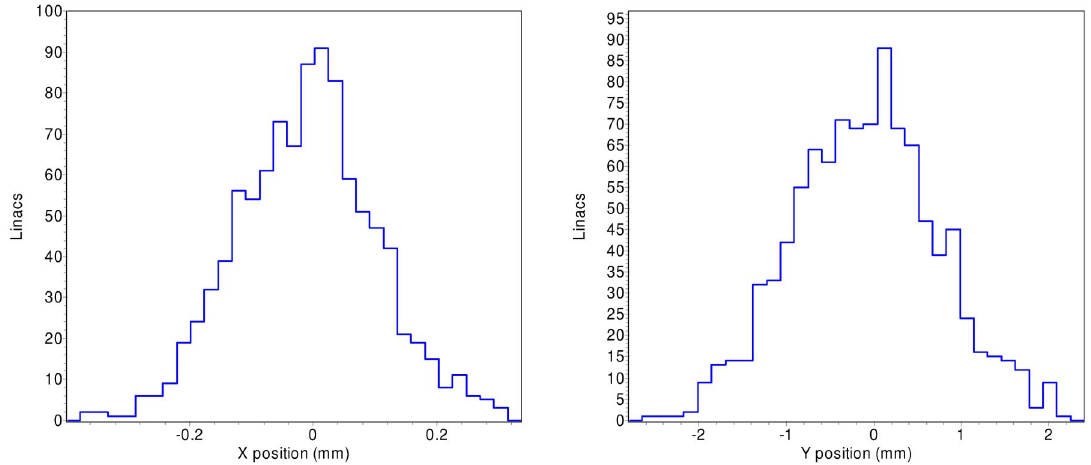
FIG. 16. (Color) Distributions for the position centers at linac exit (1000